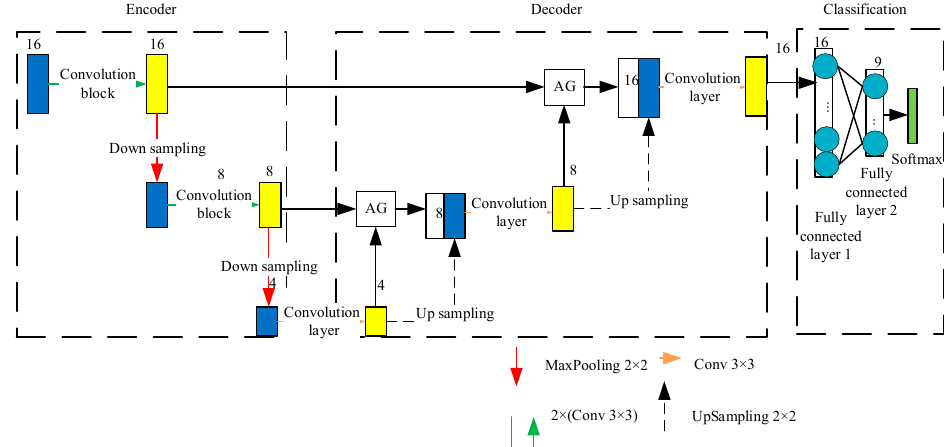
Figure 4. Structure diagram of sag recognition model based on AttUnet. computed high-level features, and x is the encoder calculated underlying features. g and x are respectively added after convolution to obtain the attention feature, and then successively pass through the ReLU activation function, a 1 × 1 × 1 convolution layer, and sigmoid activation function to finally obtain the soft attention feature attr . To have the same feature size as x , attr needs to be resampled. Multiplying the updated attr by the x of the jump connection part can enhance the sag feature spatially and control the importance of features in different positions, which can powerfully lessen the impact of noise on feature